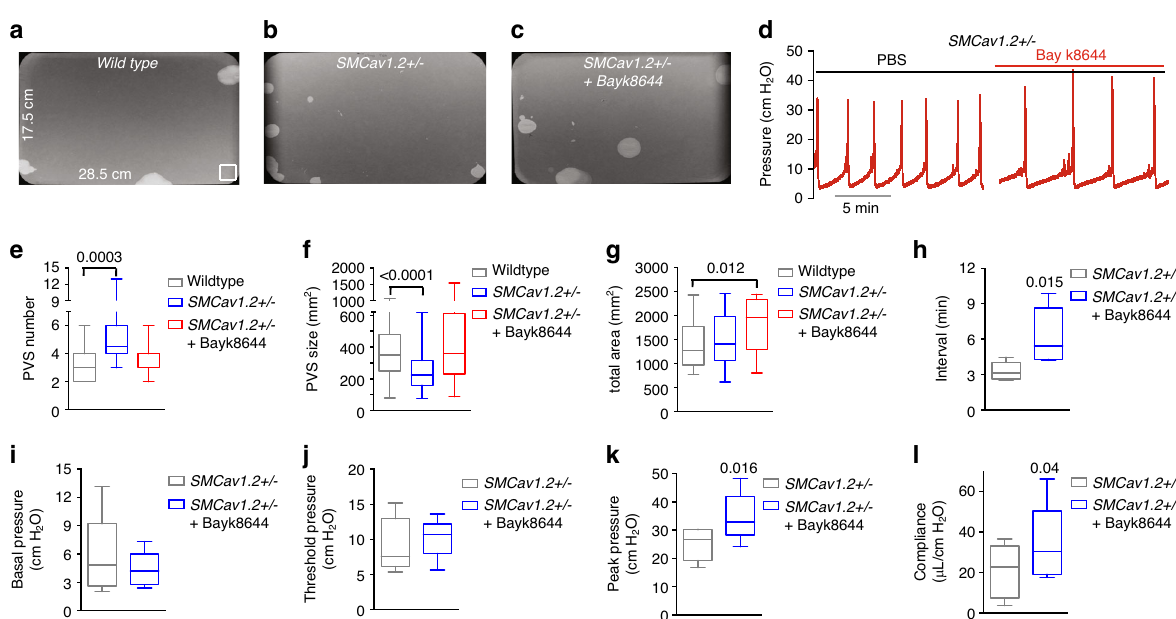
Fig. 9 SMCav1.2 + / − mice exhibit altered urodynamics mimicking ketamine cystitis. a – c Representative VSA images from SMCav1.2 + / − mice showing increased number of voids and smaller void size, both corrected by Bay k8644 (2 mg/kg i.p.). e – g ( n = 31 fi lters for wild type, and n = 18 fi lters for SMCav1.2 + / − with or without Bay k8644), summarized data indicating SMCav1.2 + / − mice have increased numbers of primary voiding spots (PVS: voiding spot area ≥ 80 mm 2 ) and reduced PVS size ( f ). d CMG traces from SMCav1.2 + / − mice. h – i ( n = 5 mice) summarized voiding interval ( h ), basal pressure ( i ), threshold pressure ( j ), peak pressure ( k ), and compliance ( l ), which were quantitated by paired t -test. SMCav1.2 + / − mice showed reduced voiding interval, smaller voiding size, reduced peak pressure and compliance, each rescued by infusion of Bay k8644 (200 nM). Data are shown as box and whiskers, center line is the median of the data set, box represents 75% of the data, and bars indicates whiskers from minimum to maximum. Data are analysed by two tailed Student ’ s t -test ( e – g ) and two tailed paired t -test ( h – l ). P < 0.05 is considered to be signi fi cant and P values are given above the bars. Source data are provided as a Source Data fi le.